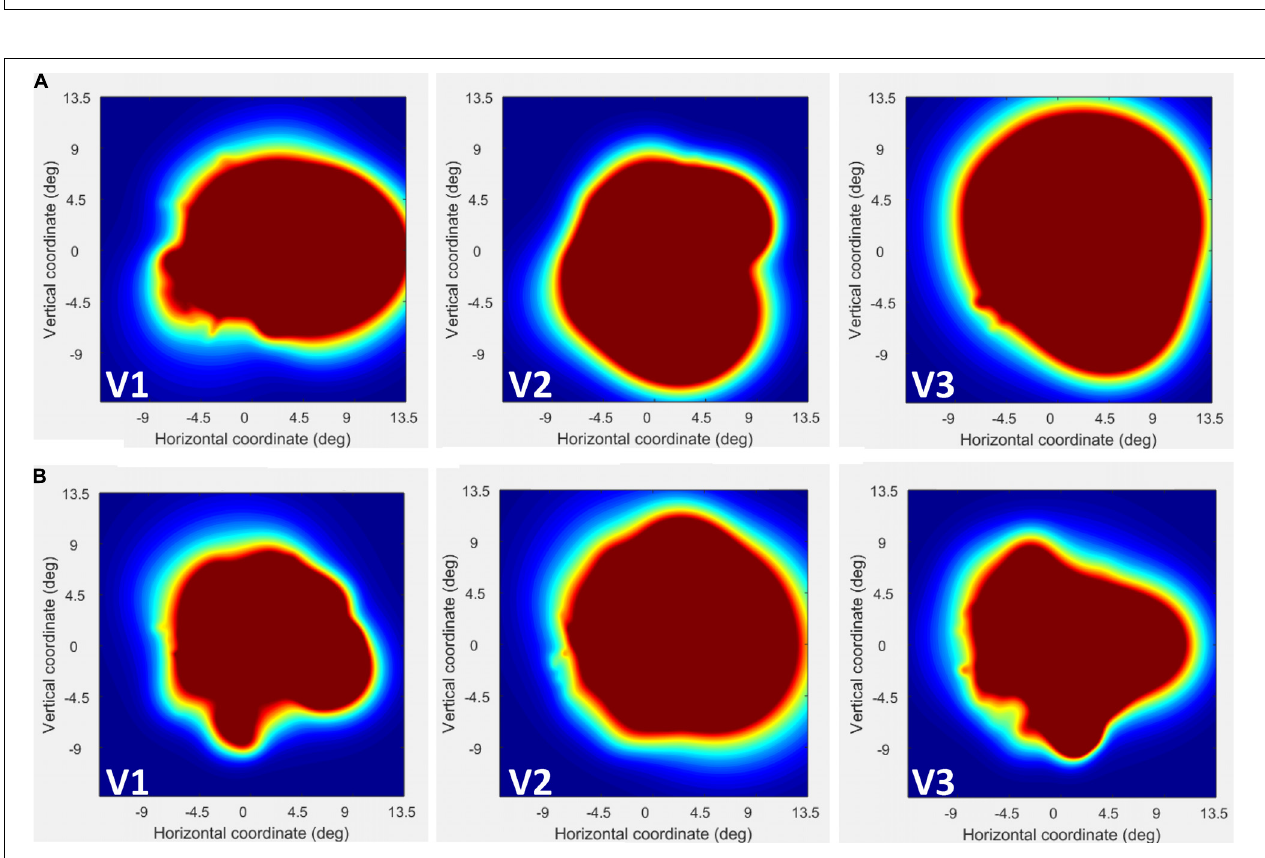
FIGURE 4 | Visual field (VF) coverage plots plotted separately in V1–V3 for CW (A) and the control participant (B) . This plots the sum of all pRFs in each area (V1–V3) as an estimate of the VF coverage. As seen the coverage for CW is constant across the whole visual field.